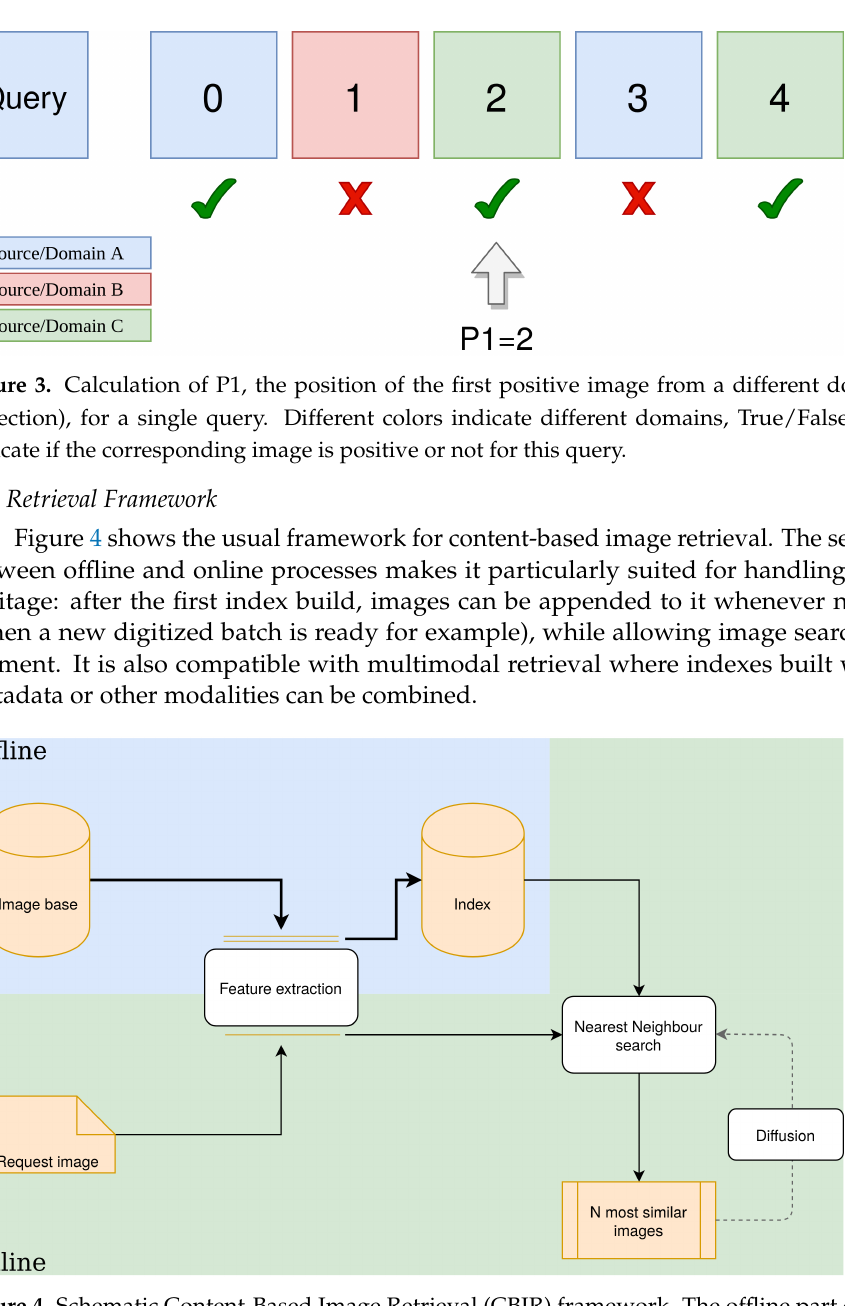
Figure 4. Schematic Content-Based Image Retrieval (CBIR) framework. The offline part computes descriptors for the whole image base and stores them in the index. The online part, using the same feature extractor, computes descriptor(s) for the query and retrieves the N most similar images using a similarity measure to get the N nearest neighbors in the index. An additional diffusion step may be used to refine the initial